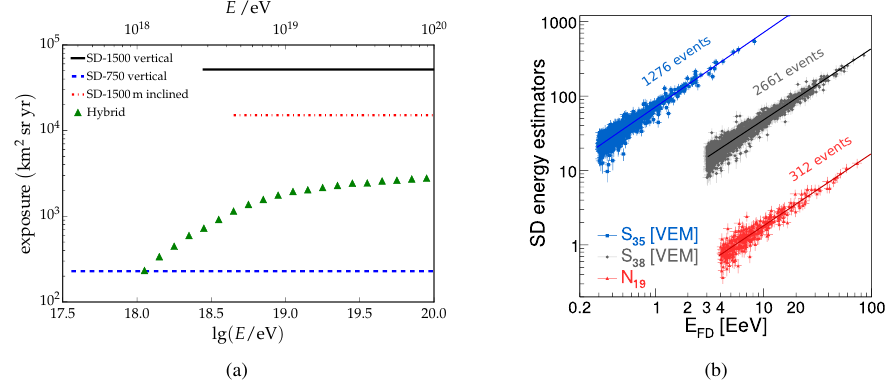
Figure 1: (a) Integrated exposure of the di ff erent detectors as a function of the energy. The SD exposure is flat above an energy corresponding to the full trigger e ffi ciency. (b) Correlation between the SD energy estimates S 35 , S 38 , N 19 and the energy determined by the